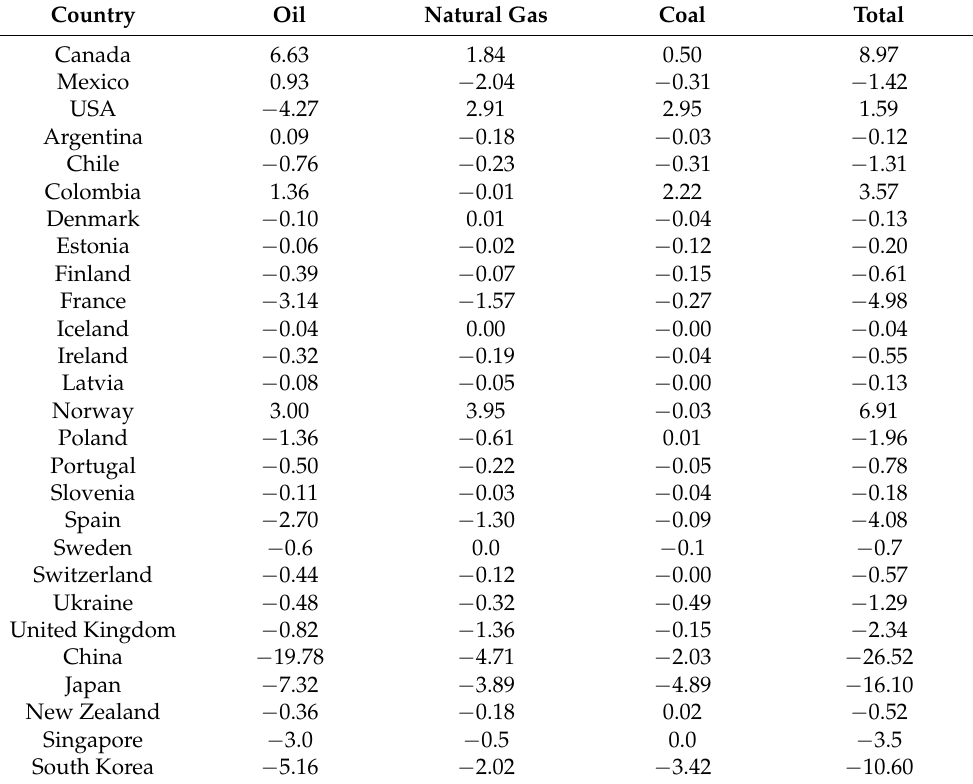
Table 2. Net external demand ( − ) and supply (+) of fossil fuels in 2019, exajoules. Country Oil Natural Gas Coal Total Canada 6.63 Mexico 0.93